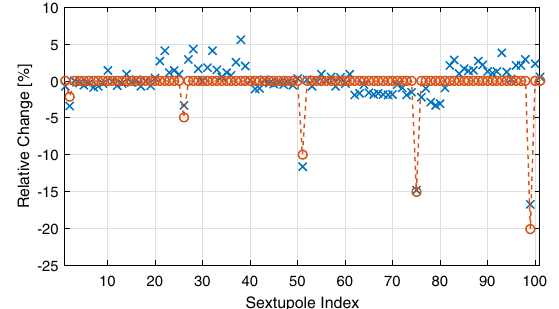
FIG. 10. Identified and introduced change in sextupole circuit strengths. The fitting procedure is able to identify all introduced errors, but a spread of errors not corresponding to the introduced errors can also be seen.